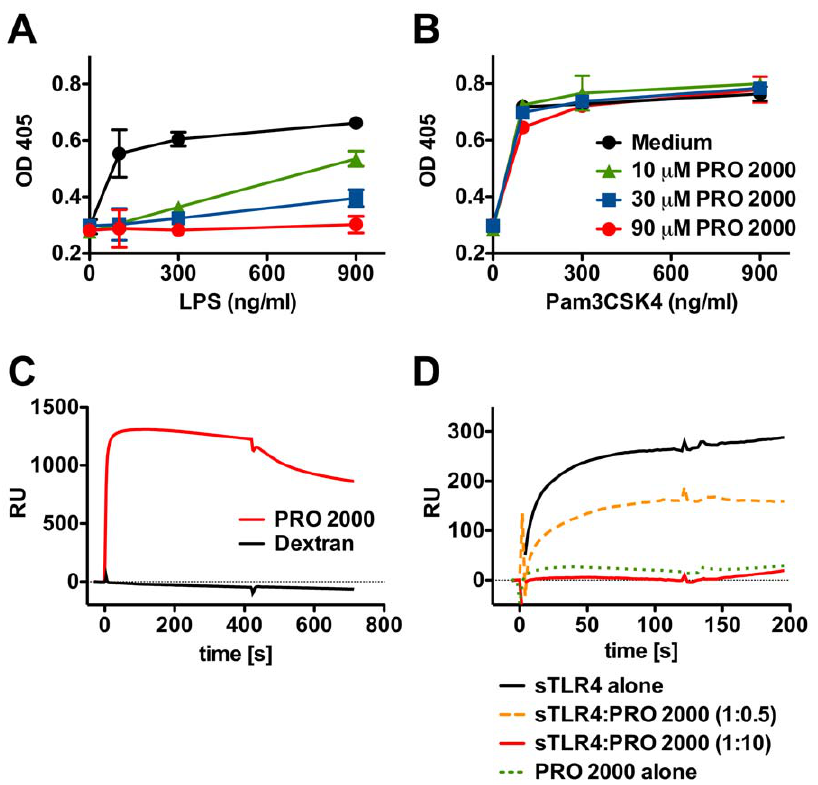
Figure 6. PRO 2000 inhibits LPS signalling and inhibits the TLR4-MD2-lipid A interaction. Murine embryonic fibroblast (MEF) TLR reporter cells were activated with ultra-pure LPS ( A , corresponding legend in B) or with the synthetic TLR2 agonist Pam3CSK4 ( B ) in the presence of 10, 30 or 90 m M PRO 2000 or in medium alone. Means of triplicates 6 SD are shown. For surface plasmon resonance binding assays ( C–D ), TLR4:MD2- complexes were immobilized on a CM5 chip ( C ), and binding of 100 m M PRO 2000 or low molecular weight dextran was observed, or lipid A was immobilized on a HPA chip ( D ) and binding of 155 nM TLR4:MD2, 1.54 m M or 77 nM PRO 2000 or combinations thereof were observed.